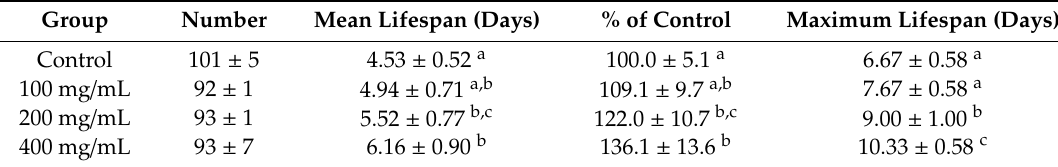
Values with di ff erent letters in the same column indicate statistical significance ( p <